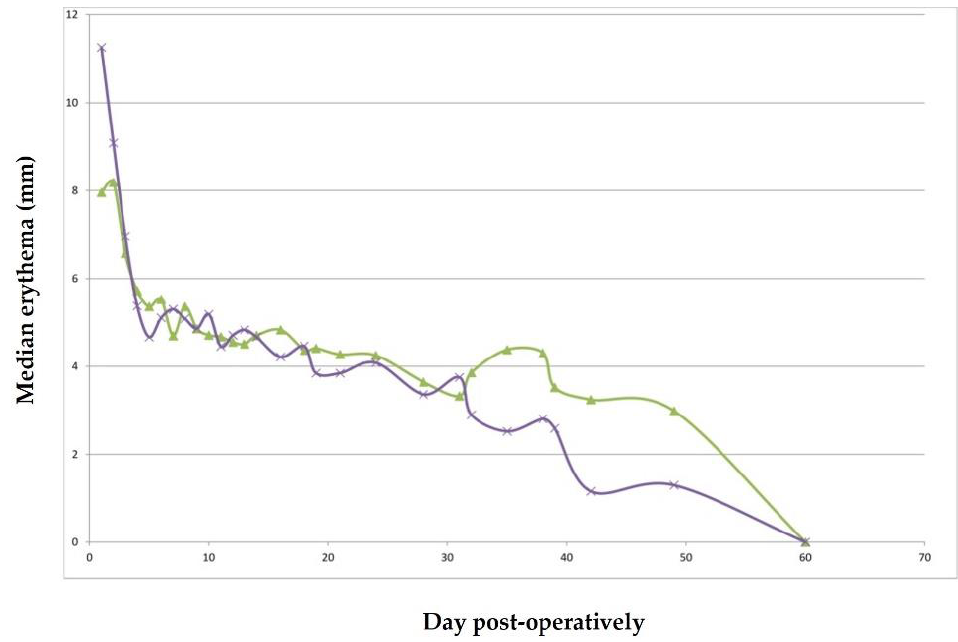
Figure 2. Median erythema (mm) for each suturing material (purple: P6211; green: P25) during the study.